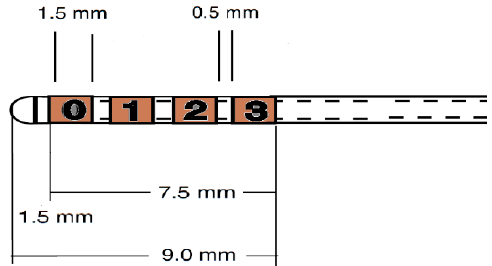
Figure 9. An illustration showing the geometry of the distal end of the 3389 deep brain stimulation (DBS) electrode model (Medtronic, Minneapolis, MN, USA) (DBS) electrode model (Medtronic, Minneapolis, MN,